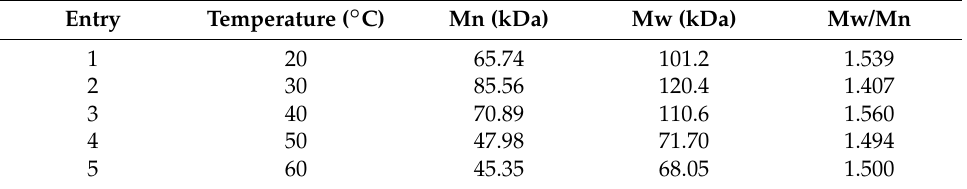
Table 4. Average molecular weights and dispersity indices of LMW-HA at different temperatures.